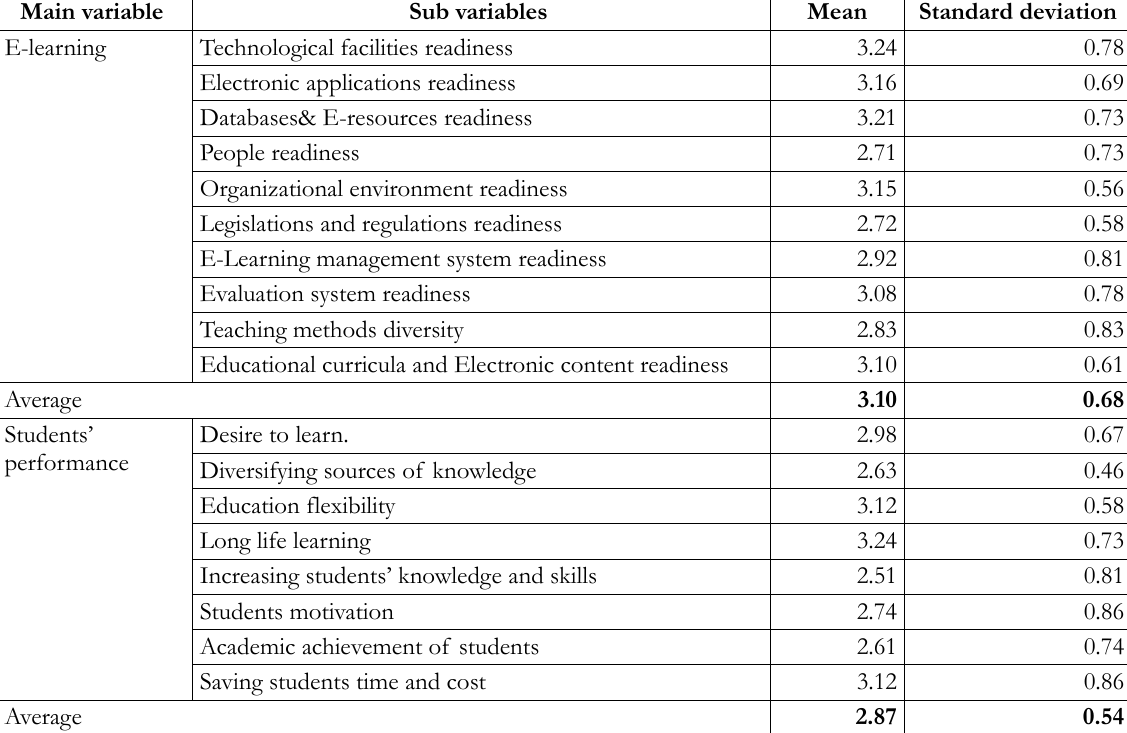
Table 1. Mean and standard deviation of the variables